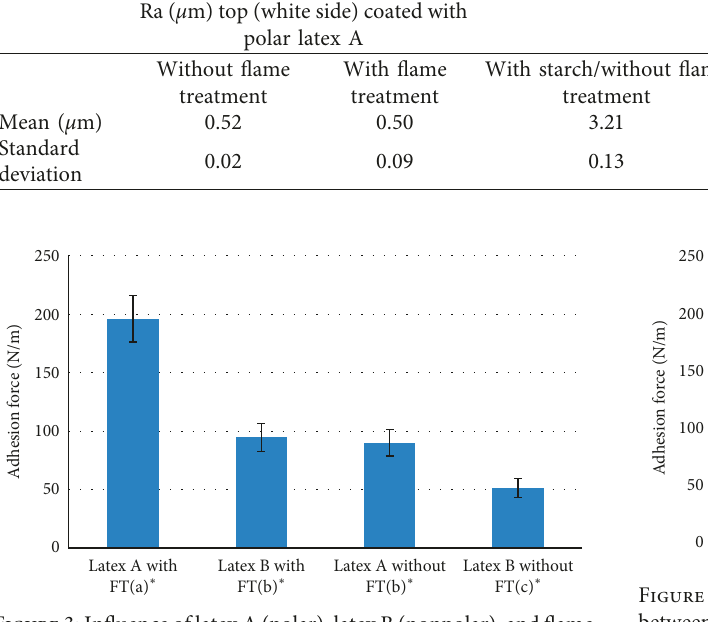
Figure 3: Influence of latex A (polar), latex B (nonpolar), and flame treatment on the adhesion force of polyethylene on the top surface of the paperboard.